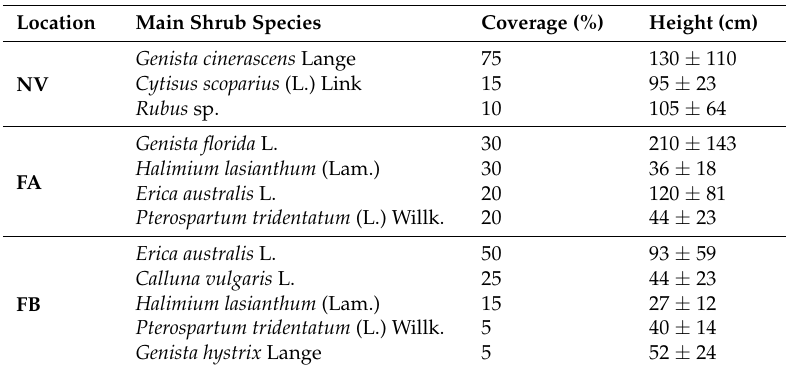
Table 2. Main shrub species and their heights (and standard deviation) and percentage of coverage at each location before harvesting.